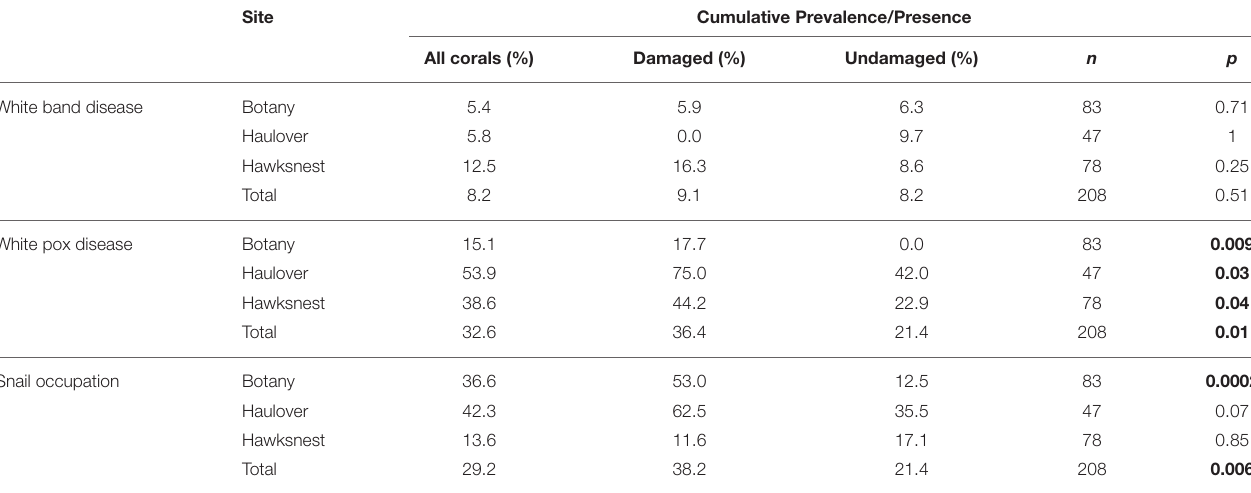
Bold values represent a statistically significant difference between damaged and undamaged corals.